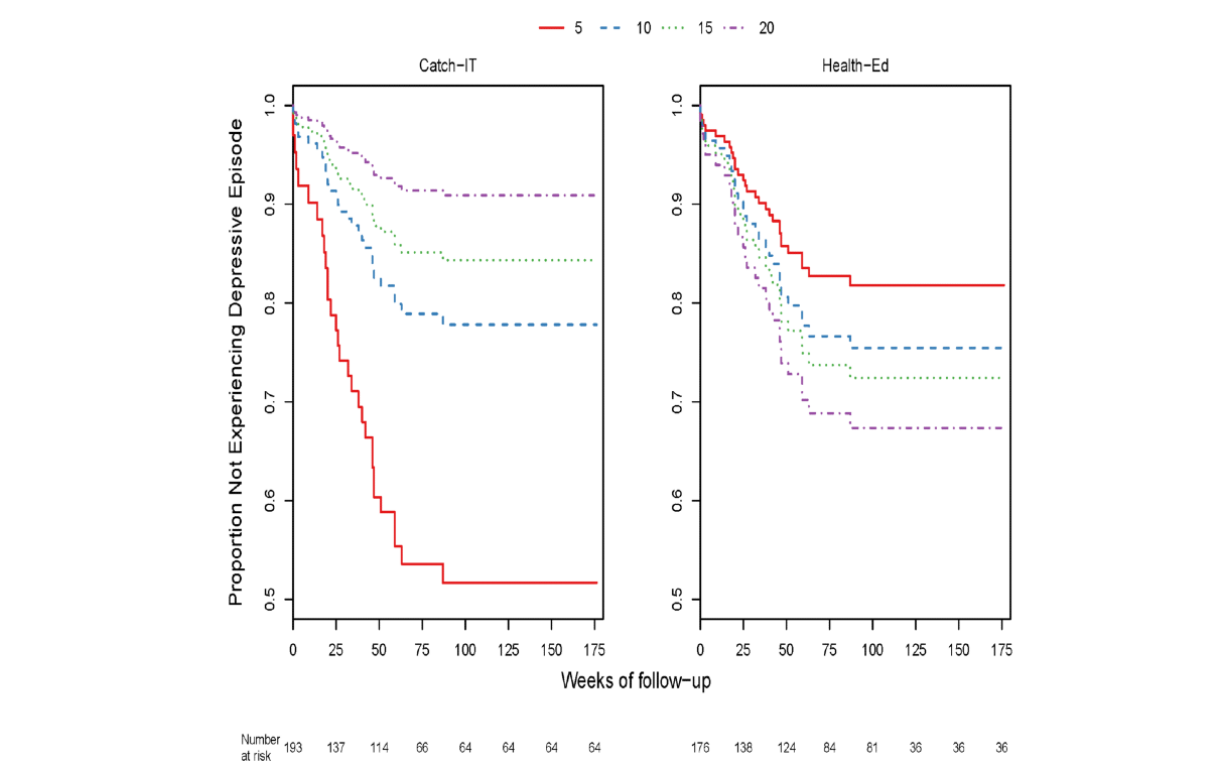
Figure 4. Adolescent Child Report of Parental Behaviour Inventory (Father Monitoring Subscale) score at baseline and time to Depression Symptom Rating>3–event at 24